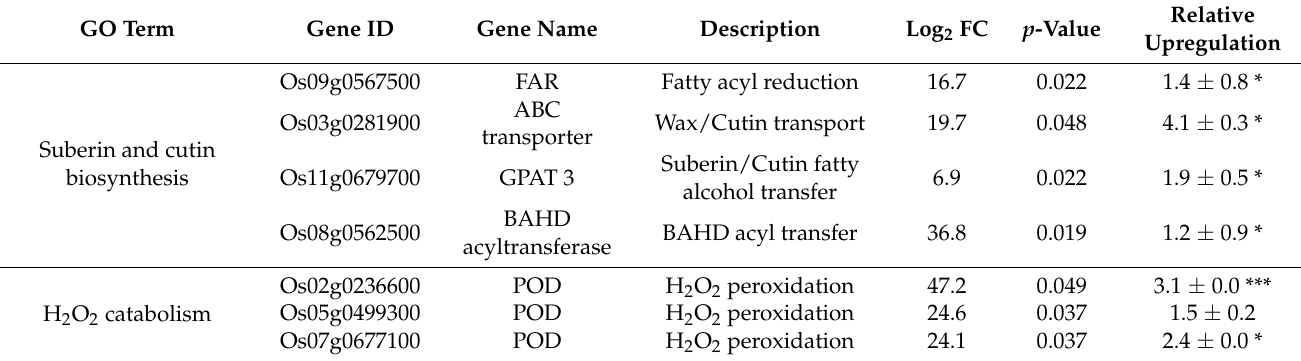
Table 2. Expression of secondary cell wall organization-related genes by RNA-seq and qRT-PCR (mean ±